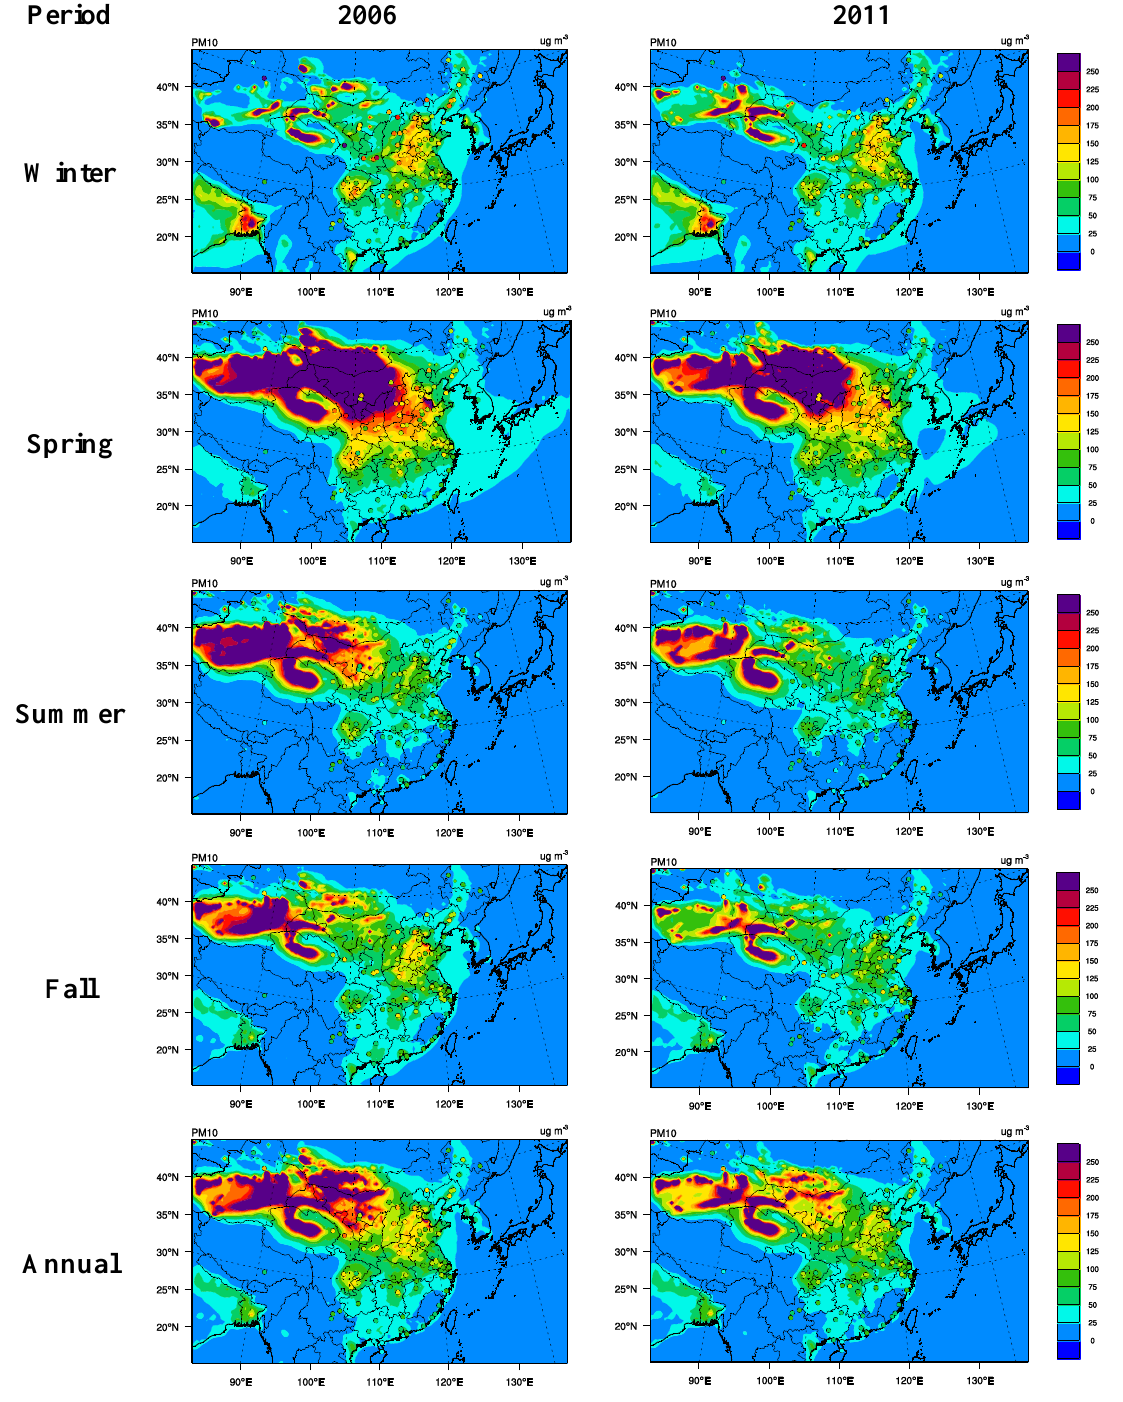
Figure 6. Simulated PM 10 concentrations overlaid with API-derived observations for 2006 and 2011 simulations with M92. The observational data are denoted as